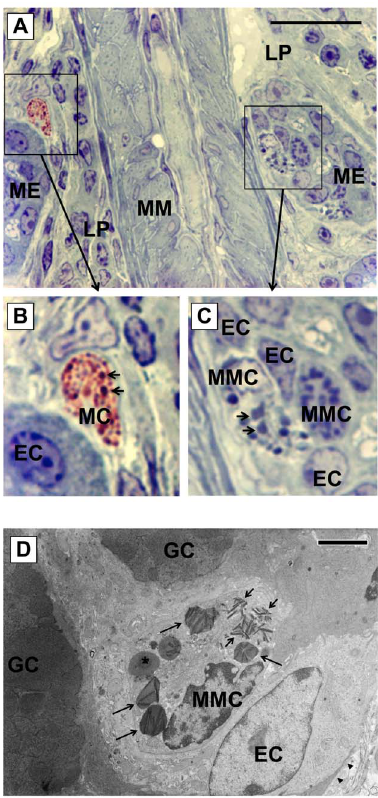
Figure 5. Morphology of mast cells in the colon of food allergy mice. Sections (1 m m thick) of the fixed colon embedded in resin were stained with 1% toluidine blue and were observed with light microscopy for the analysis of mast cells. A : On the left hand side of the picture, a mast cell (surrounded by a square) with metachromatic granules was observed in the lamina propria. On the other side, two mast cells (surrounded with another square) with nonmetachromatic granules were localized in the mucosal epithelium. ME: mucosal epithelium, LP: lamina propria, MM: muscularis mucosa. Scale bar represents 50 m m. B : An image of higher magnification of the mast cell in the lamina propria. Most of granules of the mast cell exhibited metachromasia, but a few granules (arrows) were nonmetachromatic. MC: mast cell, EC: epithelial cell. C : An image of higher magnification of mucosal mast cells (MMCs) in the mucosal epithelium. The granules in MMCs did not exhibit metachromasia and some of the granules were polymorphic in shape (arrows). MMC: mucosal mast cell. D : Electron microscopic analysis of mucosal mast cells in the proximal colon of food allergy mice. A variety of morphologies of granules was seen in a MMC: one (asterisk) showed amorphous inner structure, some (long arrows) showed crystals with amorphous matrix and others (short arrows) seemed to be occupied by the crystalline structure. Arrowheads indicate basement membrane. GC: goblet cell. Scale bar represents 4 m m.